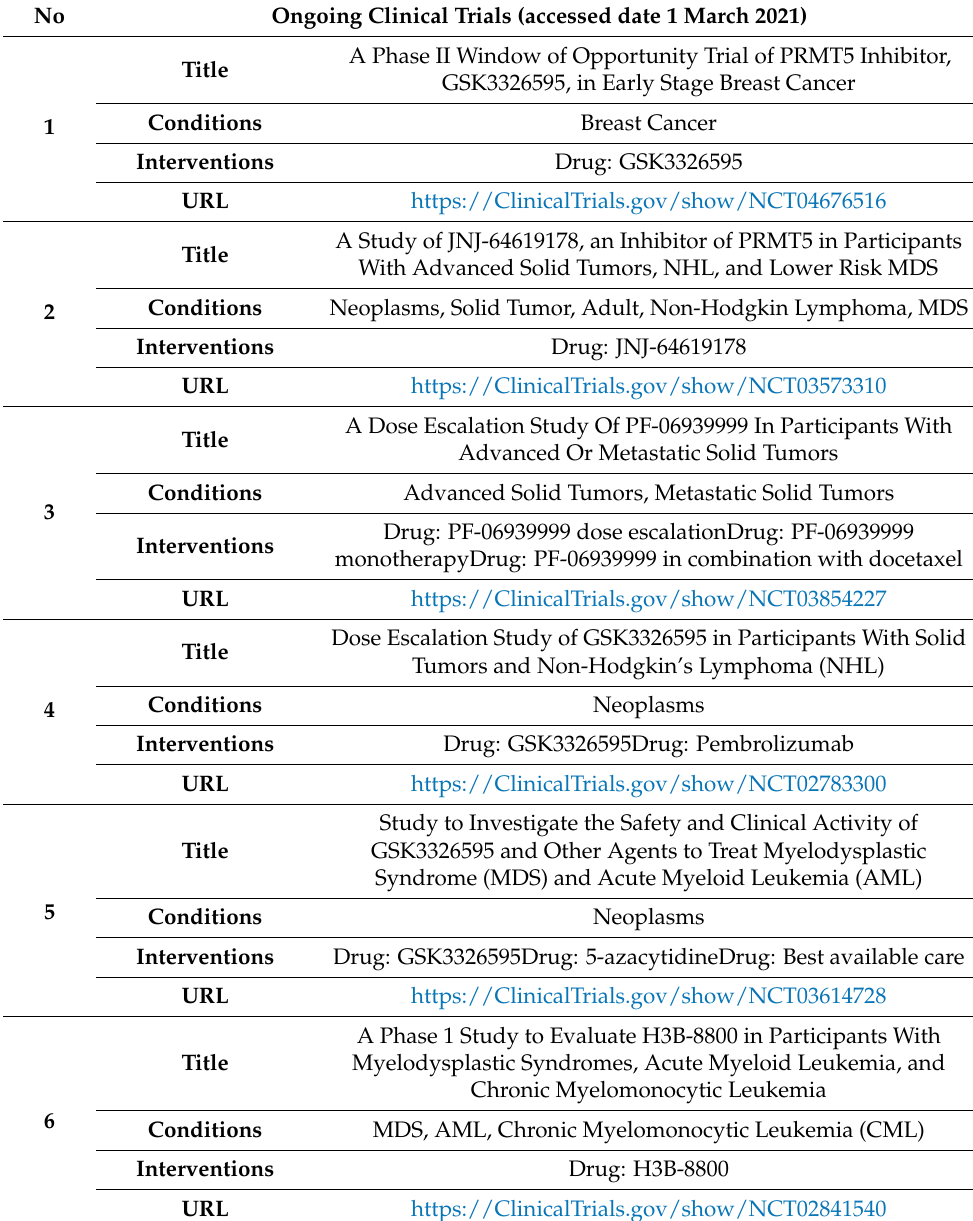
Table 3. Ongoing clinical trials associated with targeting splicing